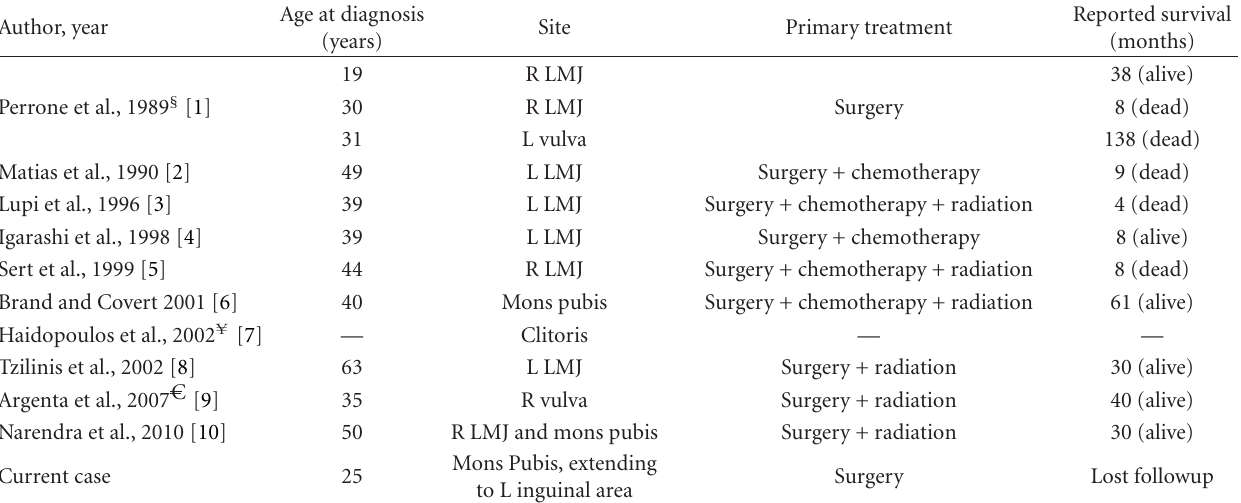
Table 1: Characteristics of the previously reported cases of EMRT of the vulva